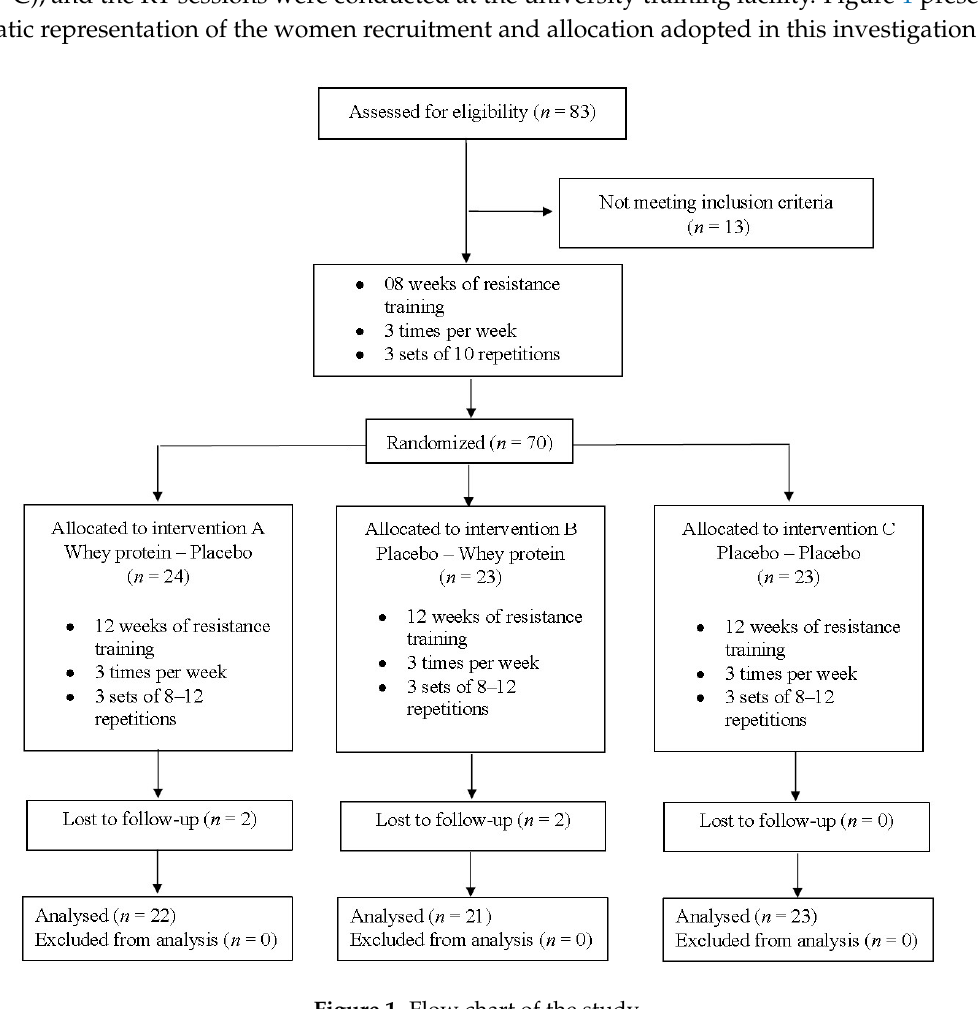
Figure 1. Flow chart of the study.